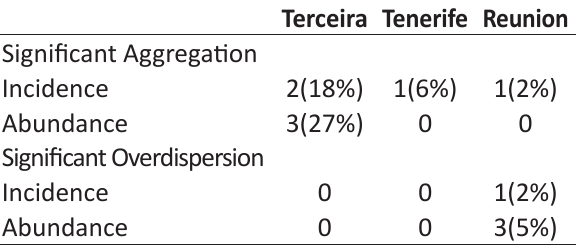
Table 3. Number and percentage of species with significant aggregation or overdispersion considering incidence and abundance data.